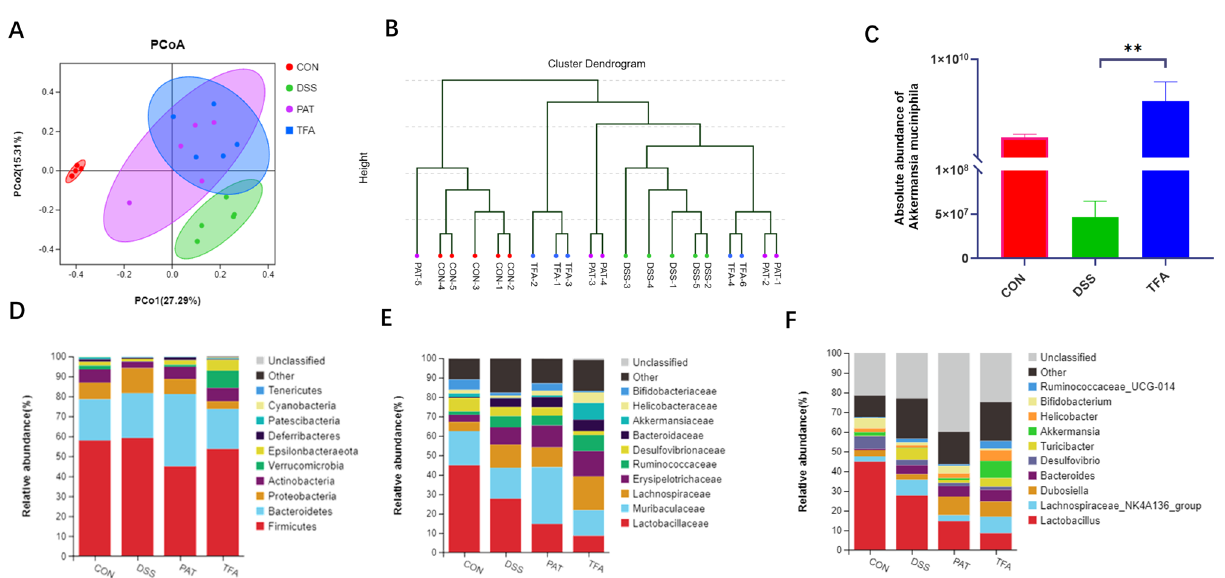
Figure 4. The composition of the gut microbiota in the treatment of DSS and administration of TFA‑H and PAT. ( A ) PCoA plot of OTU data. ( B ) Cluster analysis based on Bray–Curtis metric distances. ( C ) Absolute abundance of Akkermansia muciniphila in faecal content by qPCR. Data are shown as means ± S.E.M., ** P < 0.01, n = 5/group. ( D – F ) Relative abundance of taxa at the phylum ( D ), family ( E ) and genus ( F )